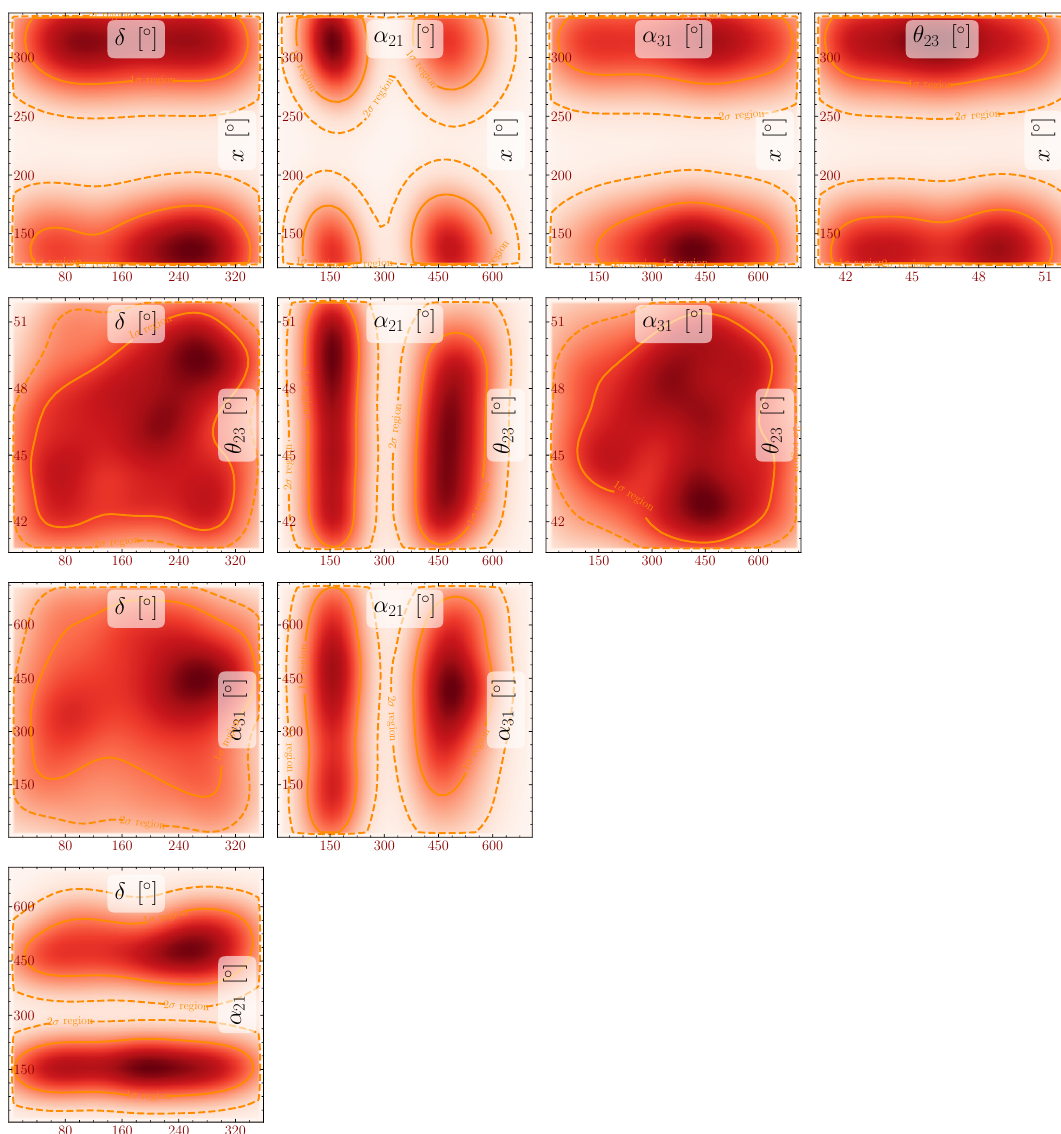
times smaller for inverted ordering, rendering the approximations of eq. (3.4) slightly less accurate than for normal ordering. Terms which were neglected and which depend on (cid:11) , contribute to a slight dip in the value of (cid:17) around (cid:11) 300 (cid:14) . The approximate 21 21 B (cid:24) independence from (cid:14) is preserved because terms in (cid:14) are multiplied by the relatively small factor s . Finally, for inverted ordering, independence of (cid:11) is exact as it does not appear 13 31 in the Yukawa matrix when m = 3